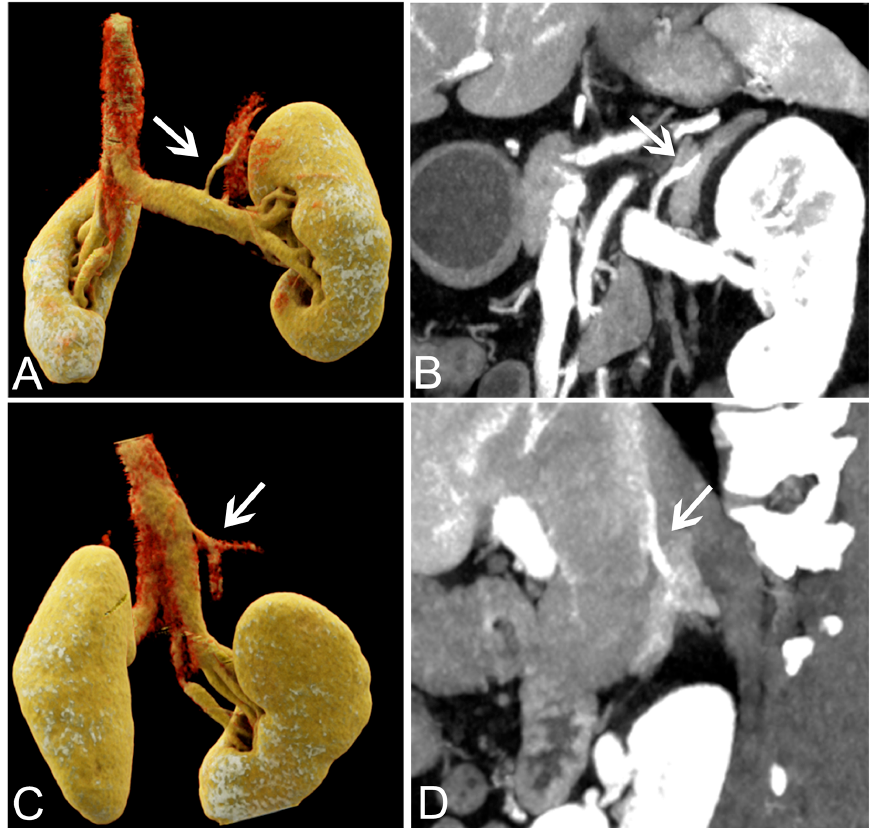
Figure 3. VR and MIP reconstructions of the adrenal veins in dual-energy computed tomography images. VR ( A ) and MIP ( B ) images of the left adrenal vein (white arrows) in a 42-year-old female patient with a left adrenal adenoma. VR ( C ) and MIP ( D ) images of the right adrenal vein (white arrows) in a 42-year-old female patient with a right adrenal adenoma. VR, volume-rendered; MIP, maximum-intensity projection. Table 4. Subjective analysis of the main abdominal organs in different